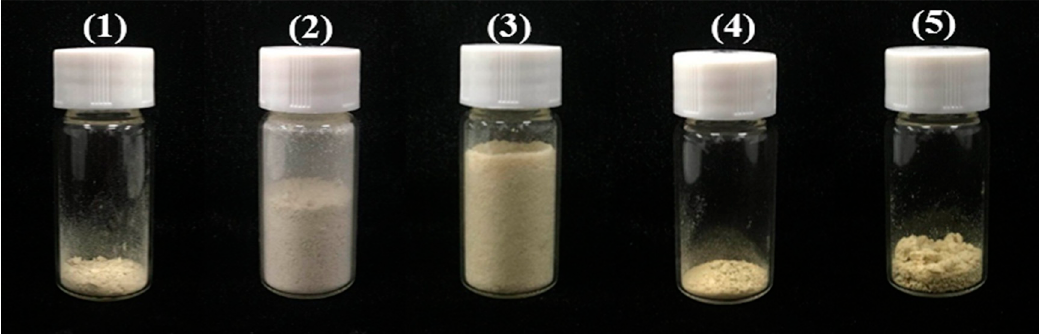
Figure 6. Five PMFs monomers obtained in this study. ( 1 ) 5, 6, 7, 4’-tetramethoxyflavone (94.8 mg); ( 2 ) nobiletin (1228.3 mg); ( 3 ) tangeretin (528.3 mg); ( 4 ) sinensetin (131.8 mg); ( 5 ) 5-hydroxy-6,7,8,3 (cid:48) ,4 (cid:48) - pentamethoxyflavone (125.0 mg).